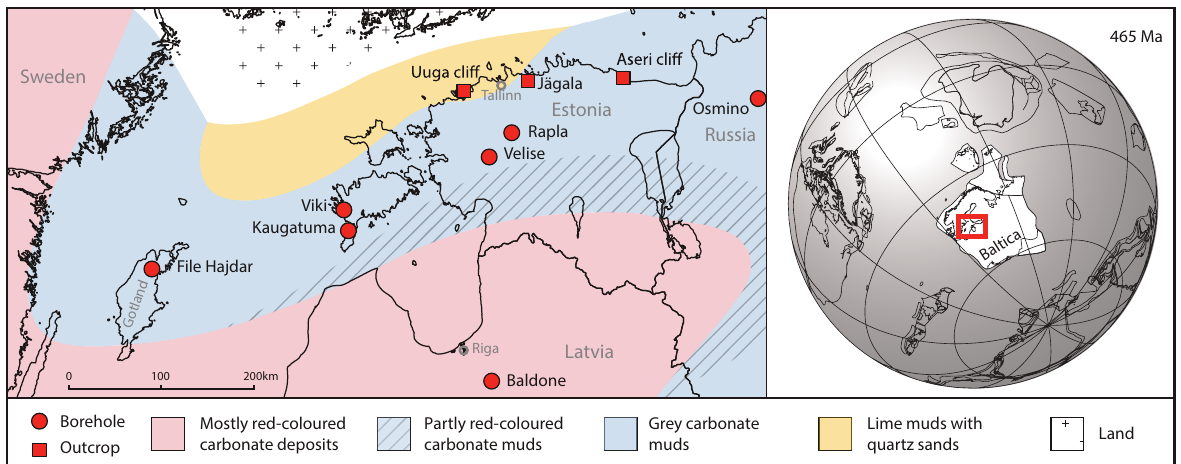
Fig. 1. Baltoscandian Palaeobasin during Kunda time, showing the spatial distribution of Vikisphaera kundana gen. et sp. nov. Palaeobasin configuration after Männil (1966); global palaeogeographic map drawn using BugPlates software (courtesy to Trond Torsvik,